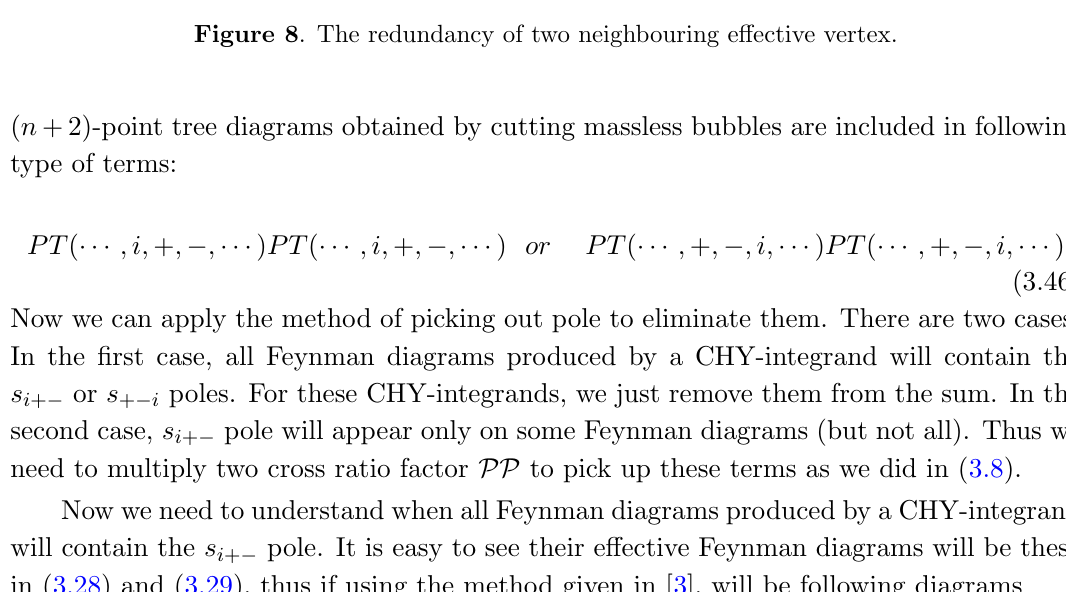
Figure 8 . The redundancy of two neighbouring e(cid:11)ective